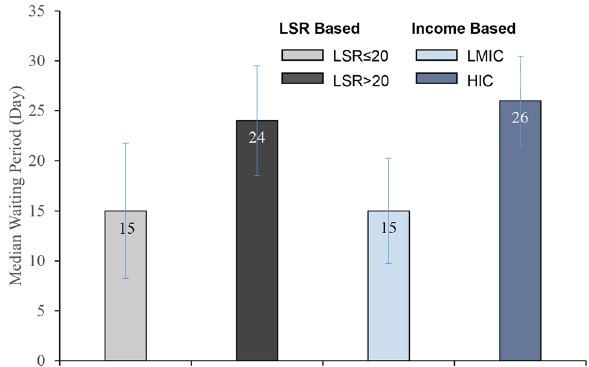
Figure 3. Median of waiting periods by two successful country groups (HIC and LMIC) and LSR index classes (LSR > 20 and LSR ≤ 20). The vertical error bars represent inter-quartile range. LSR large-scale reopening; LMIC low-income and middle-income countries; HIC high income